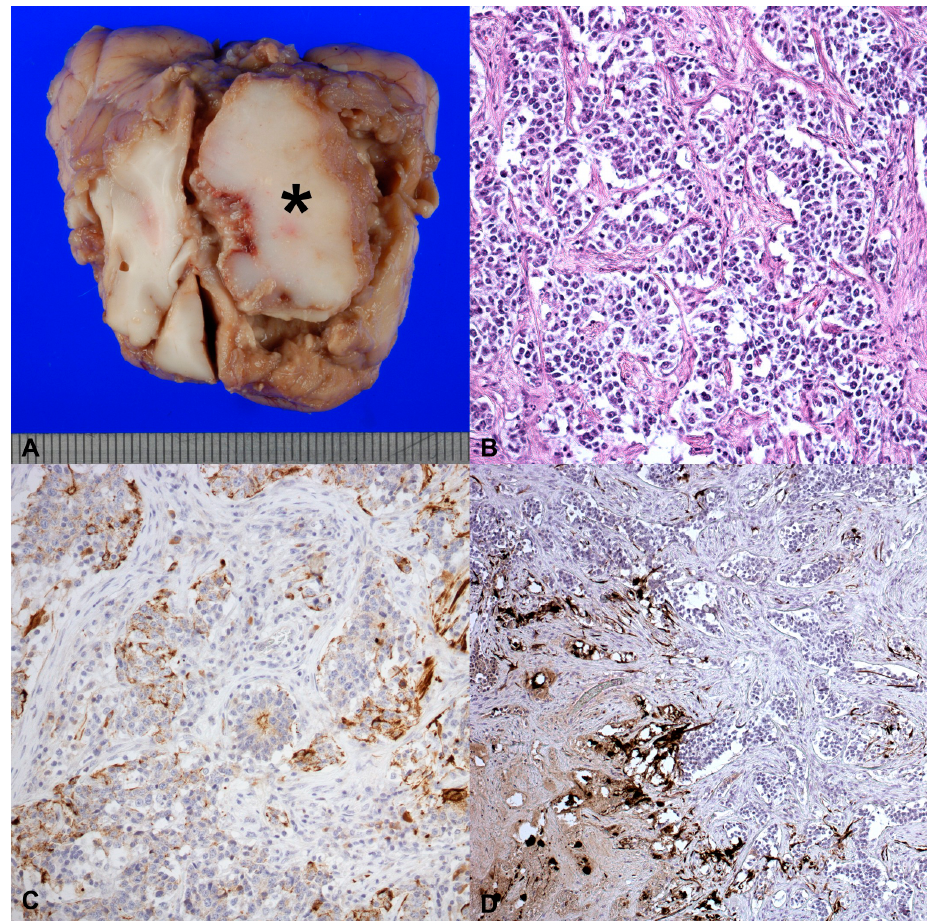
Figure 1. ( A ) Macroscopic aspect of tumor that was found in the right frontal sinus of a 5-year-old male Swiss shepherd dog, along with a wide, irregular, brown-white and firm lesion, measuring 3.5 × 3 × 3 cm, occupying the right frontal lobe and compressing the contiguous cerebral parenchyma; ( B ) Round-to-oval cells organized in sheets or pseudorosettes supported by hypocellular zones of delicate fibrillary stroma; 40×; ( C ) Neoplastic cells densely organized. The picture shows the positivity for citokeratines, 20×; ( D ) The picture shows tumor cells isolated or small cluster, that were immunopositive for NF;